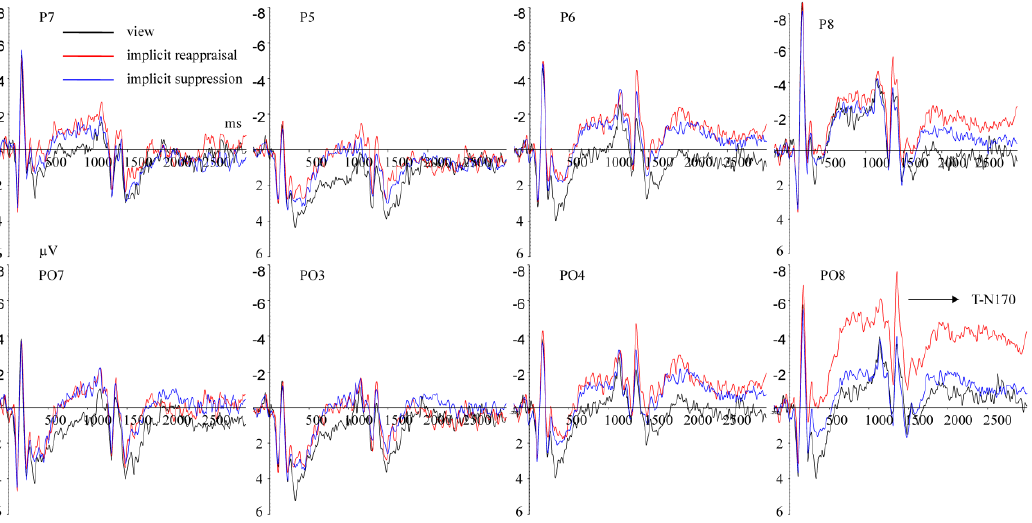
Figure 6. Grand average ERPs of T-N170 components for view (black lines), implicit reappraisal (red lines), and implicit suppression (blue lines), under implicit neutral priming condition, recorded at P5, P6, P7, P8, PO3, PO4, PO7, and PO8.